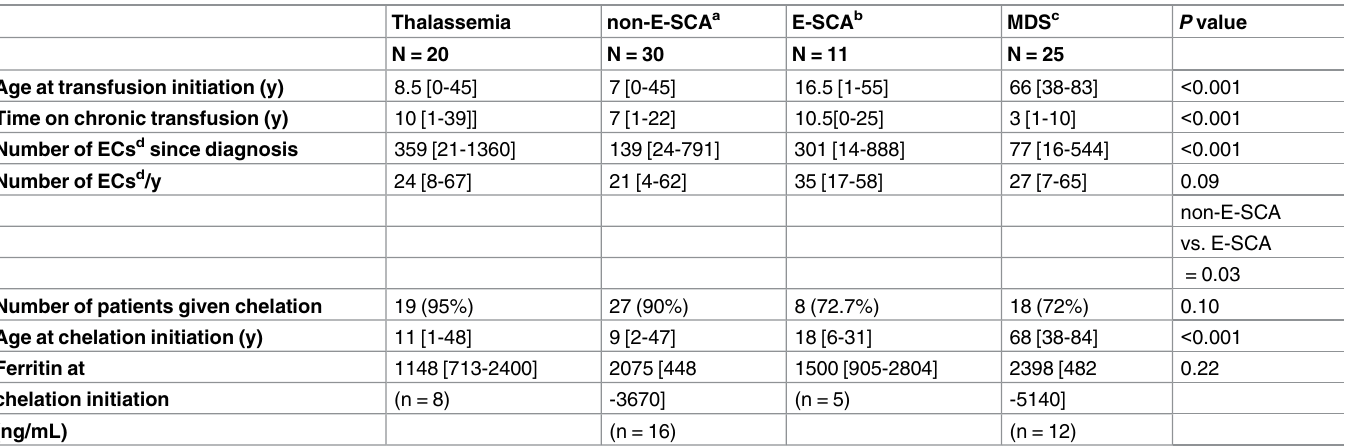
Table 2. Transfusion and chelation data.